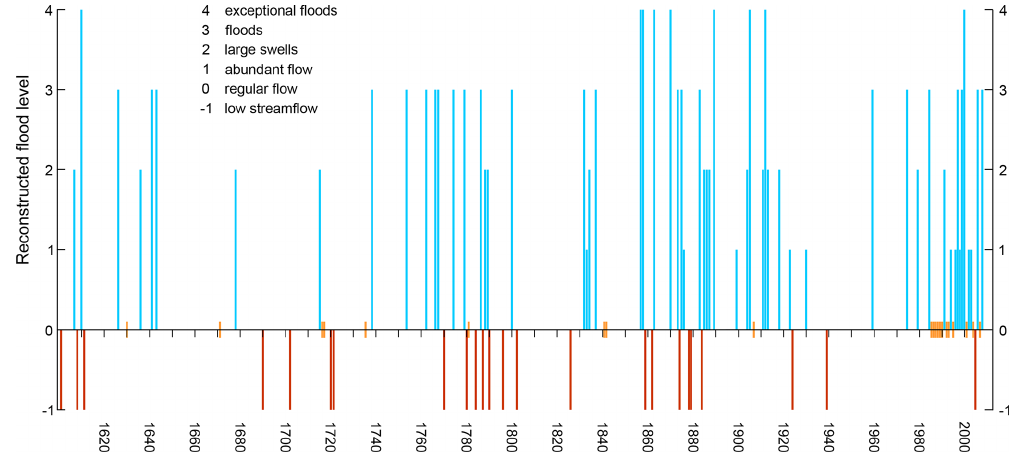
Figure 8. Six-point index series of historical flow in the Bermejo River (northern Argentina) between 1600 and 2008CE based on documen- tary evidence. These annual-level data were used to create the decadal-scale flood series in Prieto and Rojas (2015). Zero values are indicated by short orange